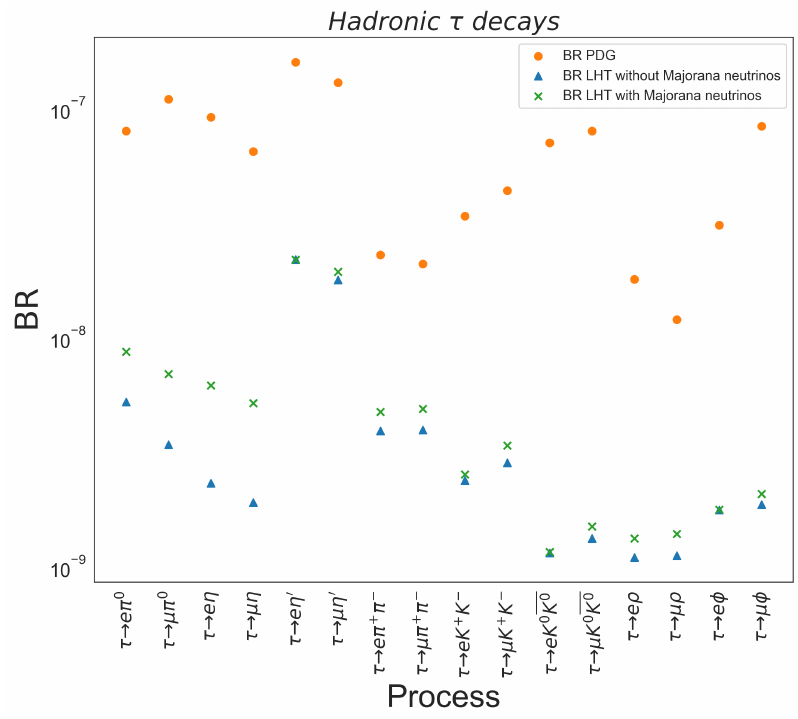
Figure 15 . Scatter plot comparing our predicted mean values with the upper limits from PDG